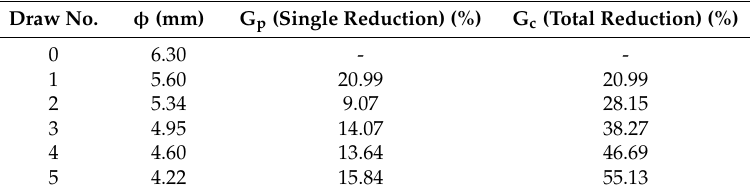
Table 2. Scheme of applied single drawing reductions and the total drawing reduction in the drawing process involving TRIP steel wire rod, in a system with low single